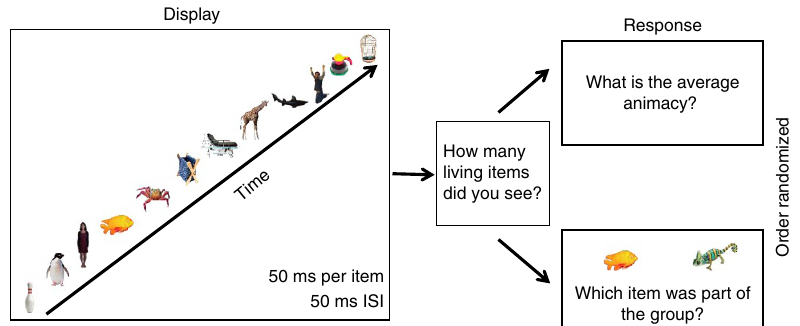
Figure 9 | Trial sequence in Experiment 7. Participants were instructed to count the number of living items in the display. They viewed 12 random stimuli displayed sequentially for 50ms per item with a 50ms ISI. Then, participants verbally reported their count to the experimenter. Afterward, the participants performed both the 2AFC membership identity task and rated the average lifelikeness of the